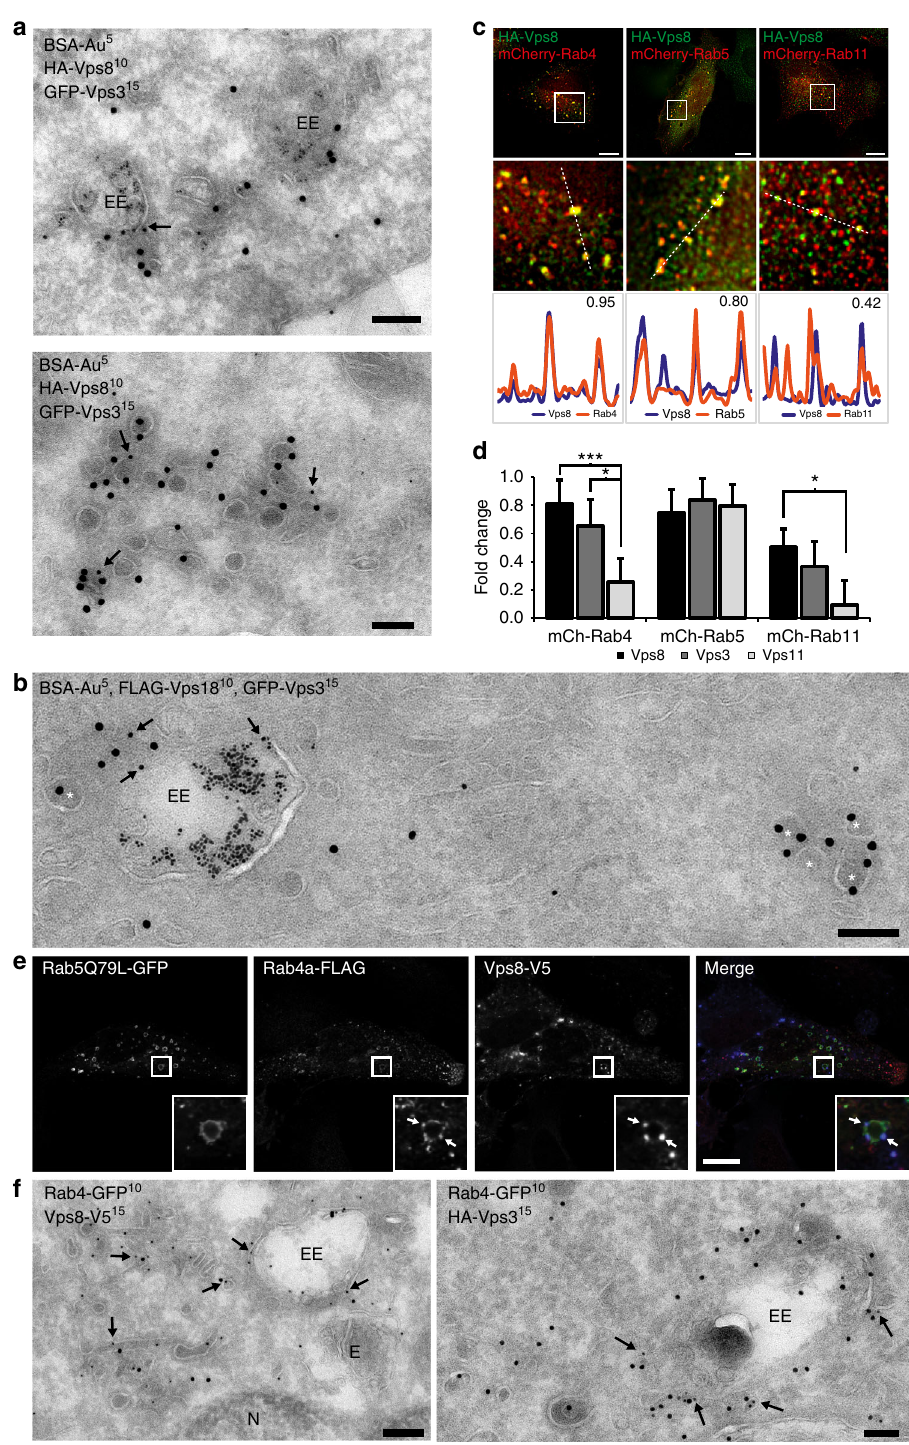
Fig. 1 Vps3 and Vps8 localise to Rab4- and Rab11-positive recycling endosomes. a IEM of HeLa cells expressing HA-Vps8 and GFP-Vps3, and loaded with BSA-Au5. HA-Vps8 (10 nm gold, arrows) and GFP-Vps3 (15 nm gold) co-localise on EEs (top panel) and on vesicles negative for BSA-Au5 (bottom panel). Bar, 100 nm. b IEM of HeLa cells expressing FLAG-Vps18, GFP-Vps3 and HA-Vps8, and loaded with BSA-Au5. FLAG-Vps18 (10 nm gold, arrows) and GFP- Vps3 (15 nm gold) co-localise on EEs but not on vesicles negative for BSA-Au5 (asterisk). Bar, 100 nm. c HeLa cells expressing HA-Vps8 together with mCherry-Rab4, mCherry-Rab5 or mCherry-Rab11. HA-Vps8 co-localises strongly with Rab4 and Rab5, and less with Rab11. Bar, 10 µ m. d Quanti fi cation of triplicate experiments shown in c based on n > 30 cells per condition. Error bars represent the standard error of the correlation coef fi cient (SEr). * P ≤ 0.05, *** P ≤ 0.001, calculated using Eqs. 4 and 5. e IF of HeLa cells expressing Rab5Q79L-GFP, Rab4-FLAG and Vps8-V5. Vps8 localises to Rab4-positive patches on Rab5Q79L-positive enlarged endosomes (arrows). Bar, 10 µ M. f IEM of HeLa cells expressing Rab4-GFP together with Vps8-V5 or HA-Vps3, showing co-localisation of Rab4-GFP (10 nm gold, arrows) with Vps8-V5 (15 nm gold, left panel) and HA-Vps3 (15 nm gold, right panel) on recycling tubules and vesicles. Bar, 200 nm. E endosome, EE early endosome, N Nucleus. * P ≤ 0.05, *** P ≤ 0.001 using Student ’ s t